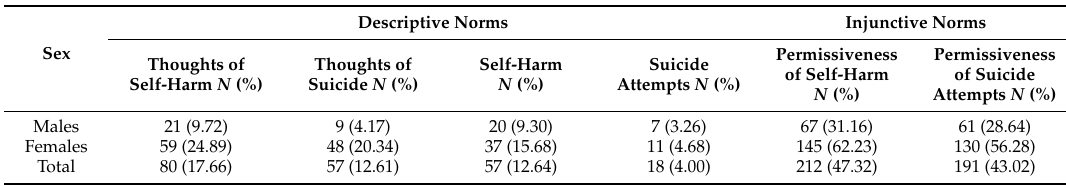
Table 1. Descriptive data relating to reported norms.